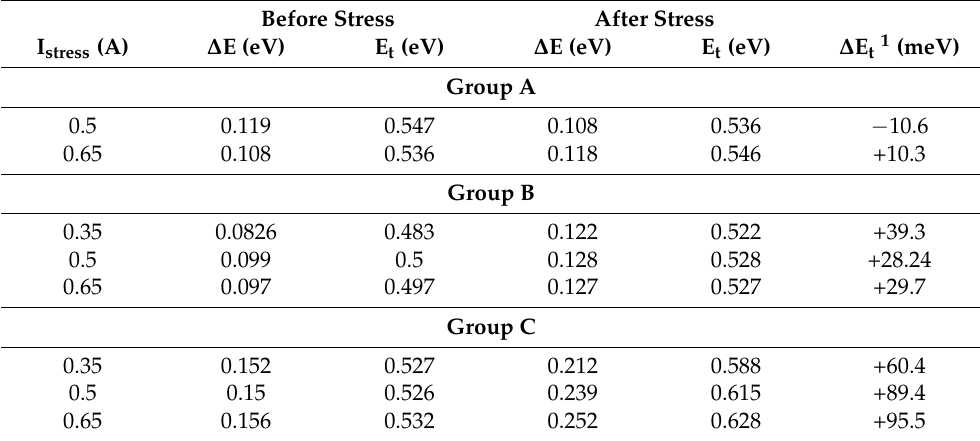
Table 1. Estimated trap level values before and after 9000 min of constant-current (CC) stress at different bias levels. The measuring point chosen for the estimations was I = 600 µ A. Before